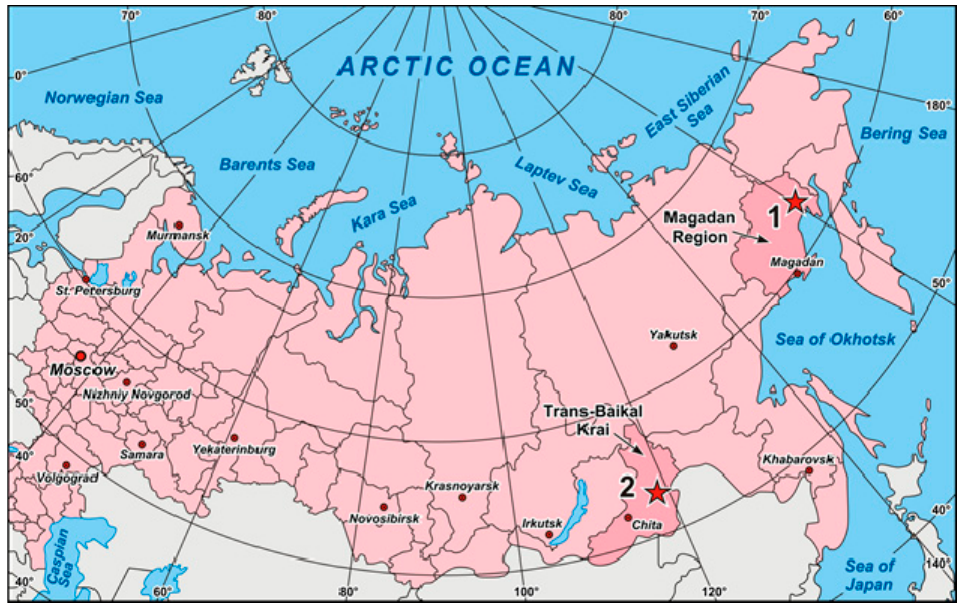
Figure 1. Location of the Kvartsevaya Sopka ( 1 ) and the Amurskie Daiki ( 2 ) gold deposits within the territory of the Russian